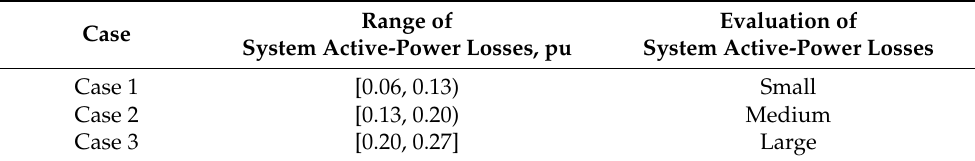
Table 11. System Active-Power Losses Characterizing the Considered Study Cases.